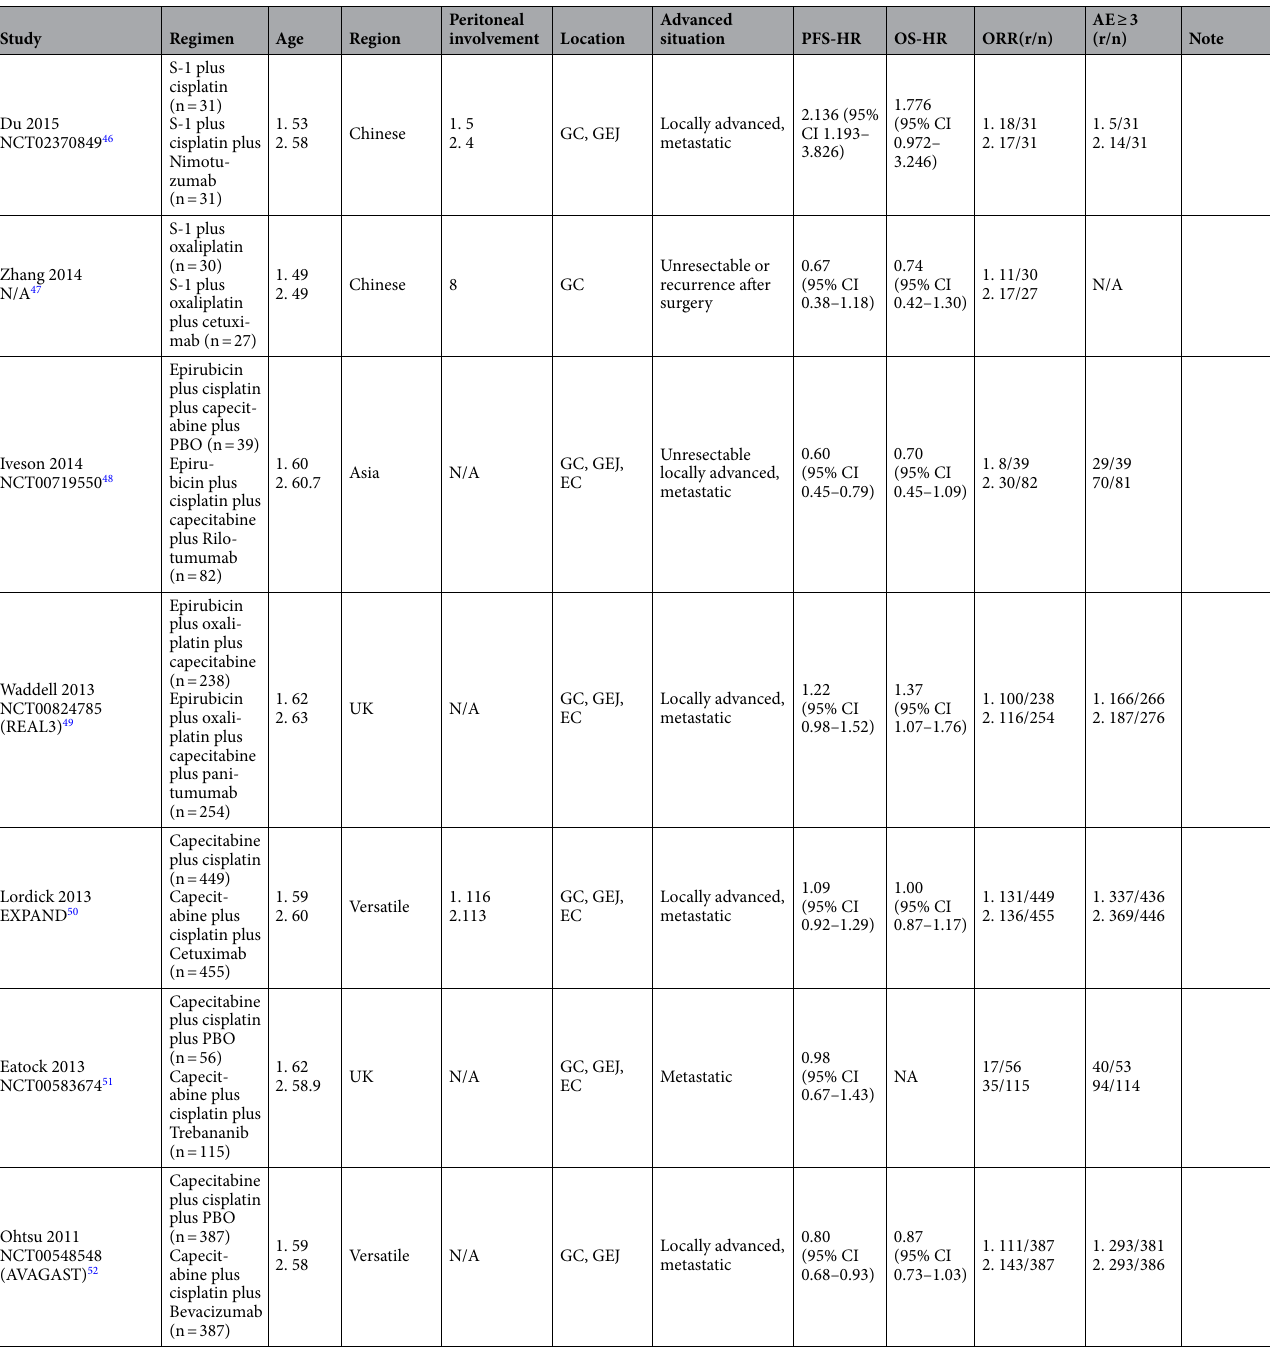
analysis data in subgroup of esophageal adenocarcinoma. Three trials included AGC cases only with metastasis, while others also included locally inoperable and recurrent cases. To confirm the comparable baseline, studies with potential heterogeneity were checked for their influence by sensitivity analysis. Network plots of primary outcomes, PFS and OS, are presented in Fig. 2C,D. Baseline characteristics of included studies are summarized in Table 2.